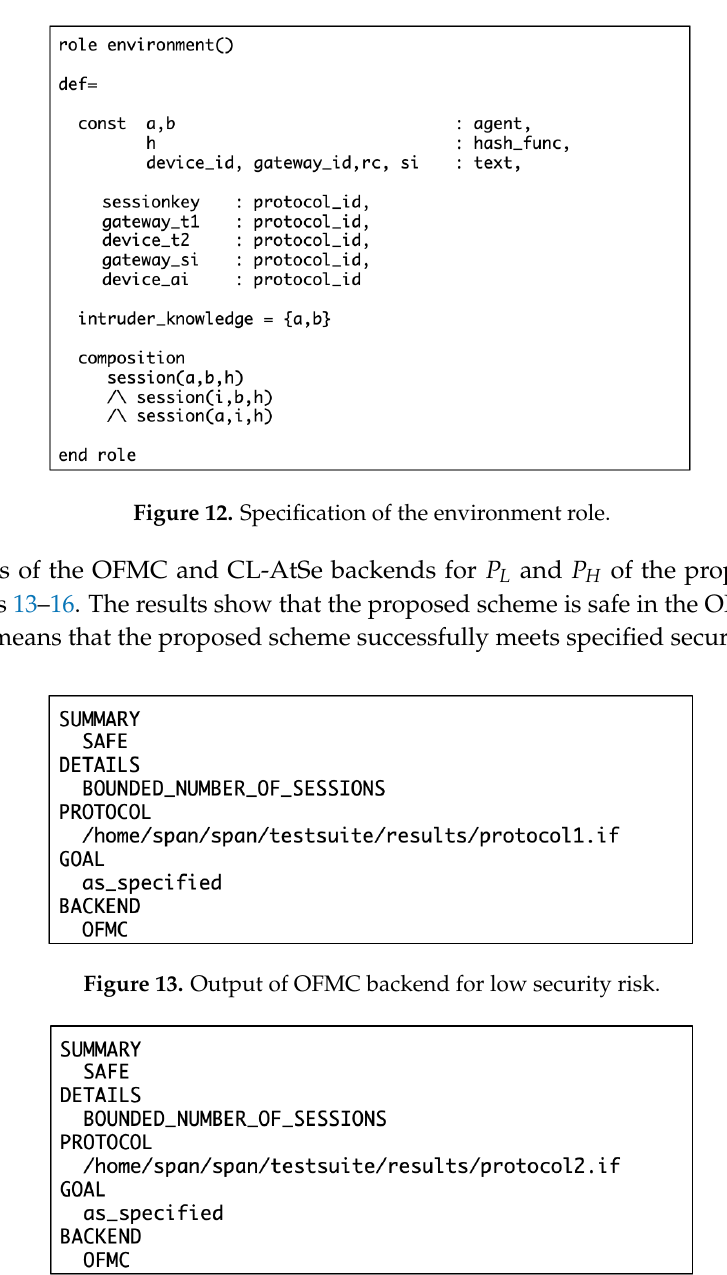
Figure 11. Specification of the session role.